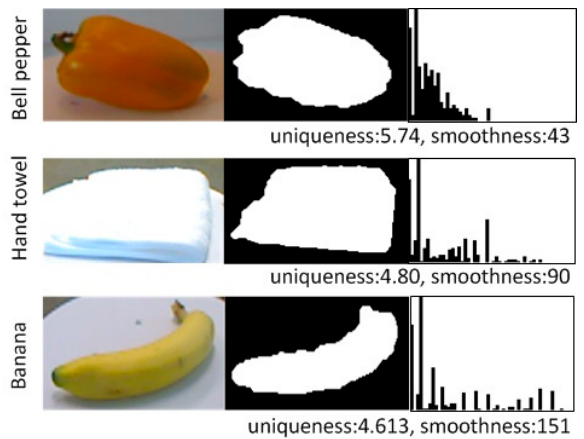
Figure 6 analyzes the histogram of the tangent vector angle difference for the selected categories. For the bell pepper category, the contour changed slightly and the angle difference between the two adjacent tangent vectors was small. This notion is reflected in the histogram image, where one can see that most of the angles are distributed in the lower angle region. For the hand towel category, the contour mainly consisted of two types; straight lines and right angles. This is also reflected in the histogram, where angles are mainly centered around zero degrees (left) and the 90 ◦ region (center). For the banana category, the contour consisted of smooth curves and sharp angles, hence the distribution was mainly centered at the lower angle (left) and the higher angle regions (right).